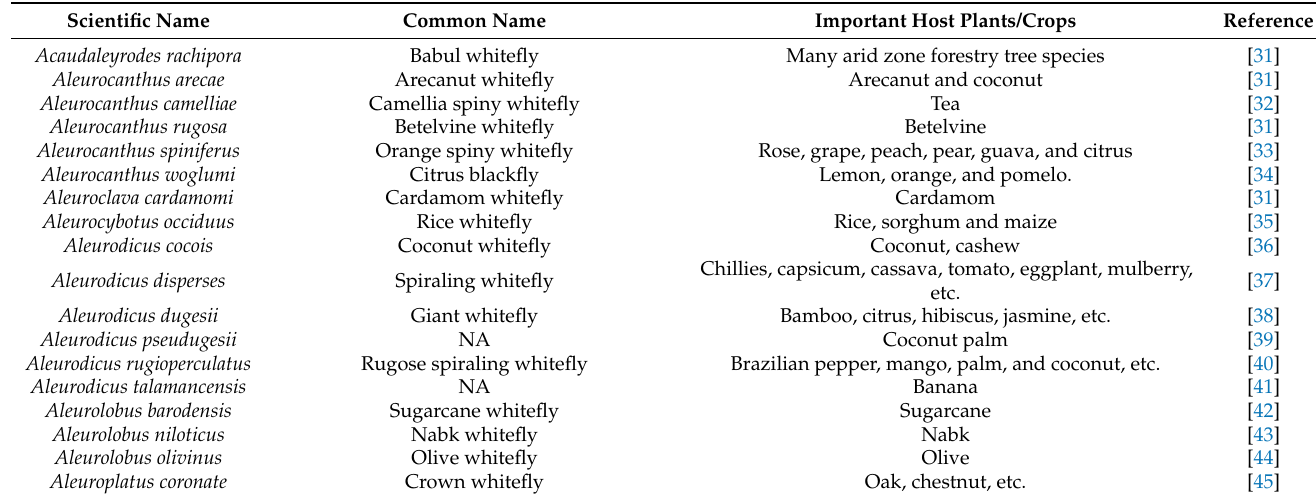
Table 2. Economically important whiteflies and their host